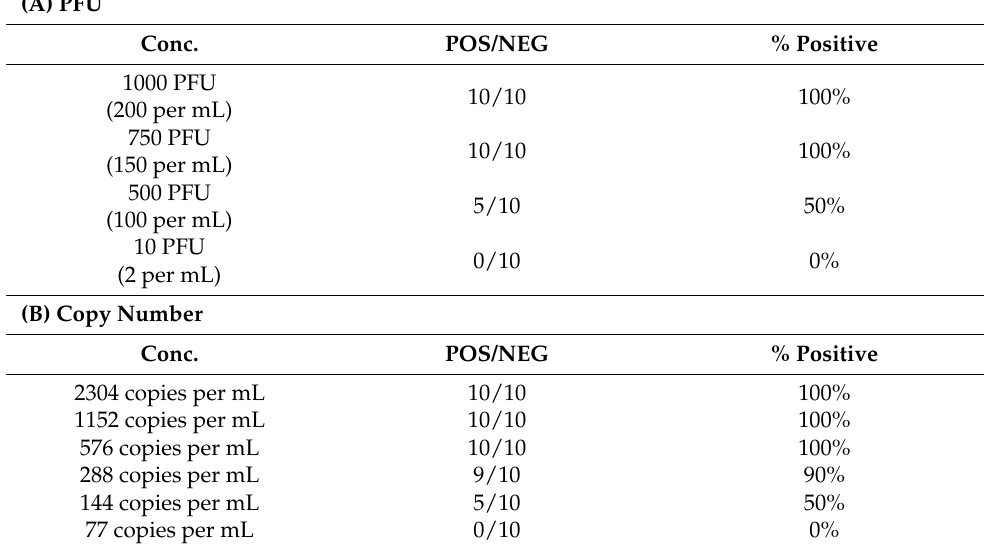
Table 1. Tabulated dilutions of SAR-CoV-2 to determine the consistency of detection in the MALDI– ToF MS test and limit of detection (LoD), measured as: ( A ), biological plaque forming units (PFU) determined from serial dilution of in vitro culture media of SARS-CoV-2 (Wuhan) spiked into negative saliva-gargle; and ( B ), quantitative rtPCR determined copy number of SARS-CoV-2 from a positive sample dilutes into negative